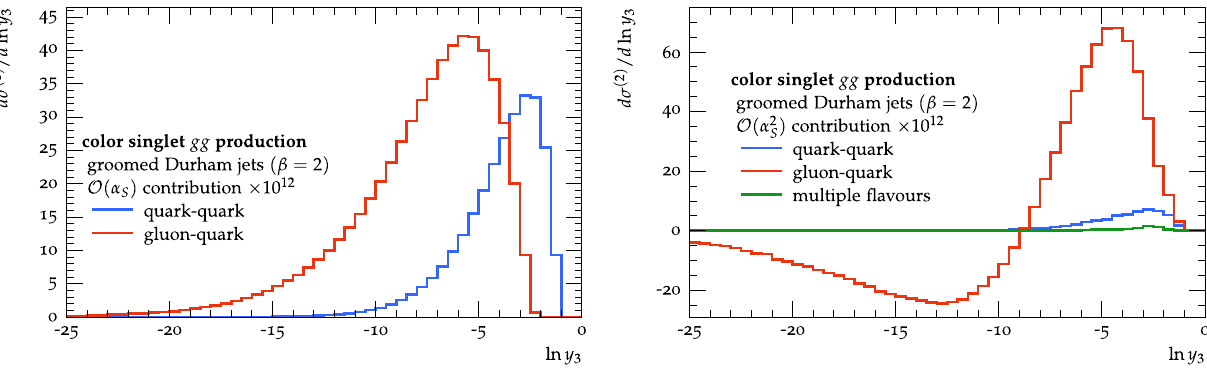
Fig. 4 NLO (left) and NNLO (right) contributions to the cross section as a function of the y 3 jet resolution of the event, for different assignments of flavour to the two jets obtained from Durham clustering, according to the jet constituents after SD grooming with β = 2 reclustered with J